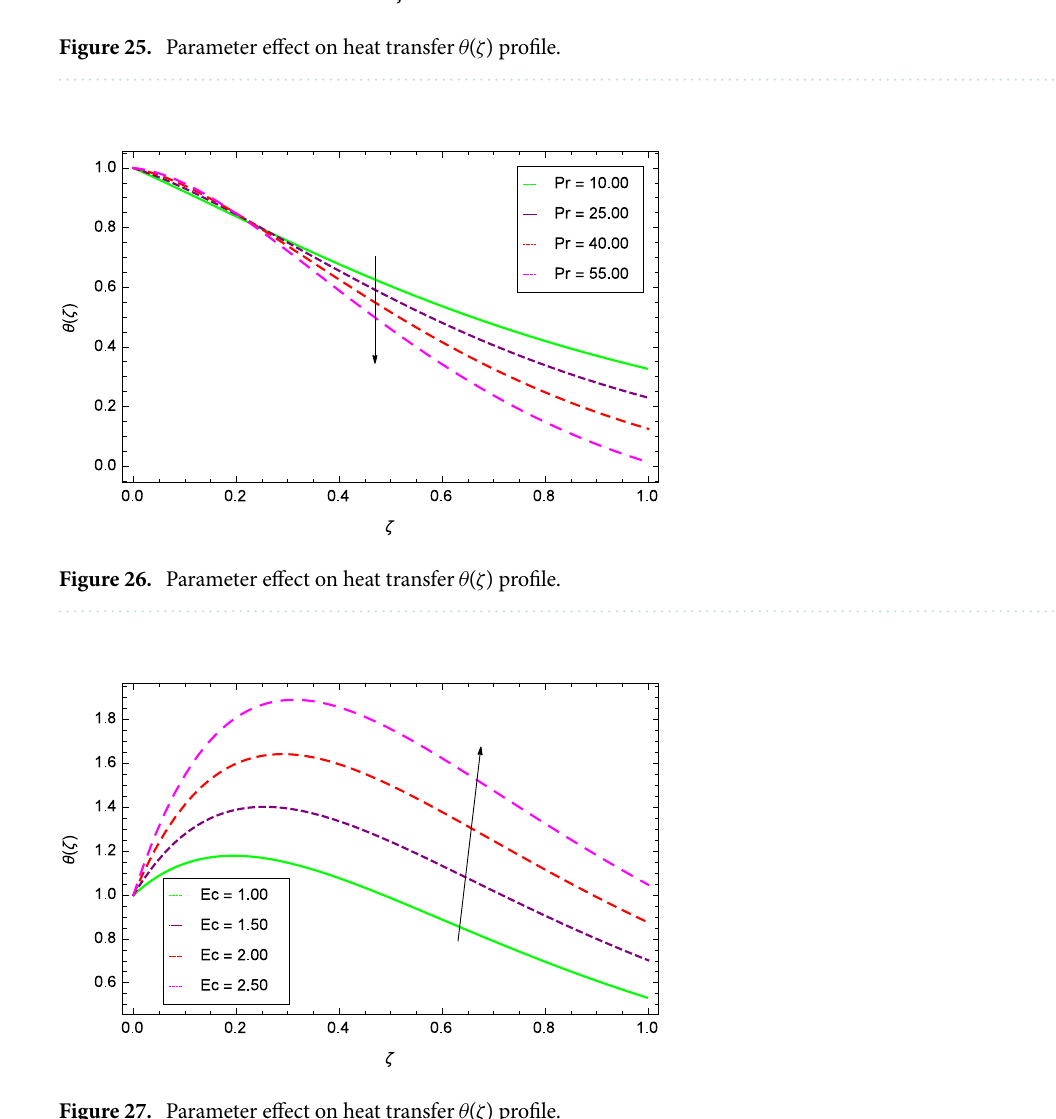
Figure 27. Parameter effect on heat transfer θ ( ζ )